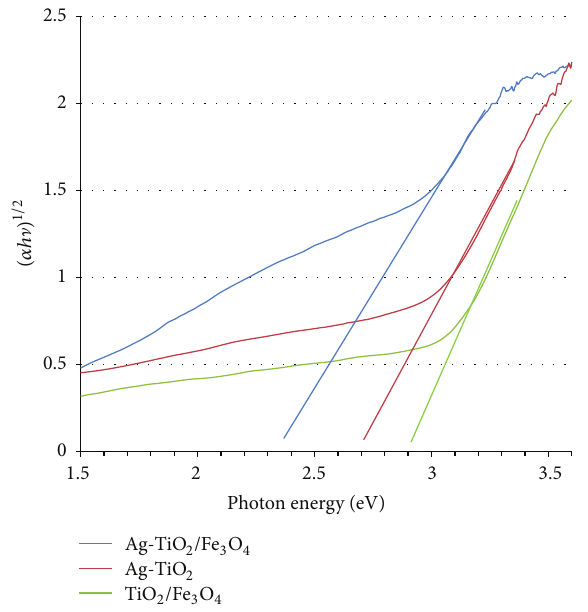
Figure 3: Tauc plot for the determination of band gap for the as- synthesized samples.